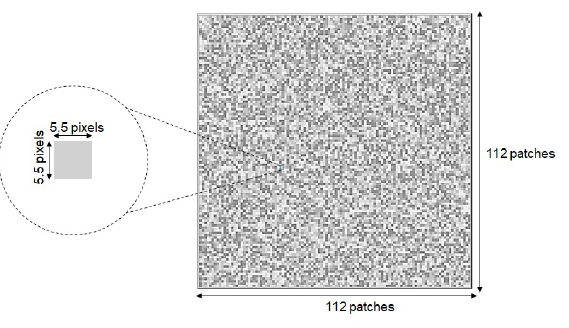
Figure 4. Arena specifications ratio. The circle on the left displays an enlarged